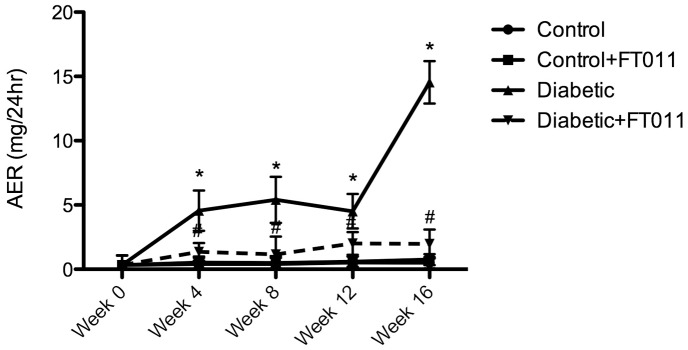
Albuminuria in diabetic rats.Albuminuria, expressed as mean ± SEM, developed in untreated diabetic animals during the course of the study and to a lesser extent in rats receiving FT011. #
P<0.05 versus vehicle treated diabetic rats.